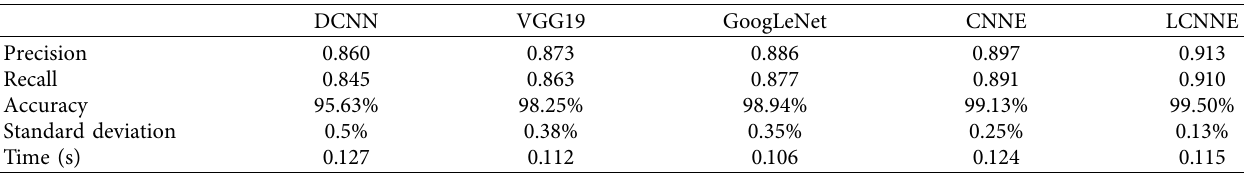
Table 2: Performance comparison of five models.